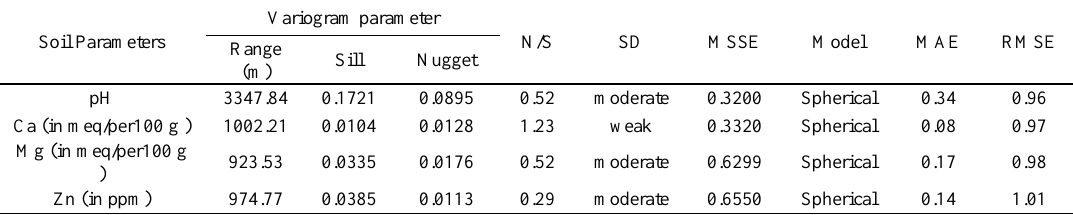
Table 4. Semivariogram parameters for soil pH, Ca, Mg and